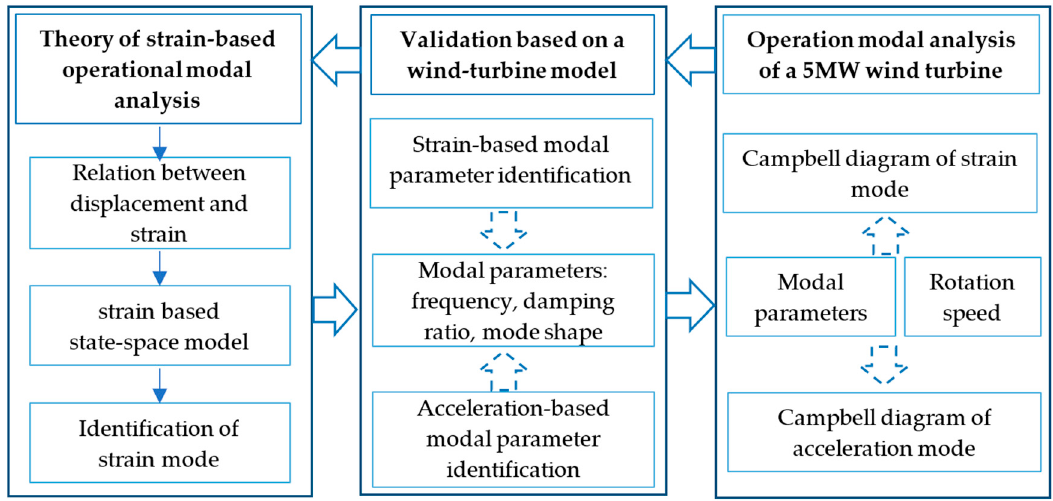
Figure 1. A flowchart of the paper.